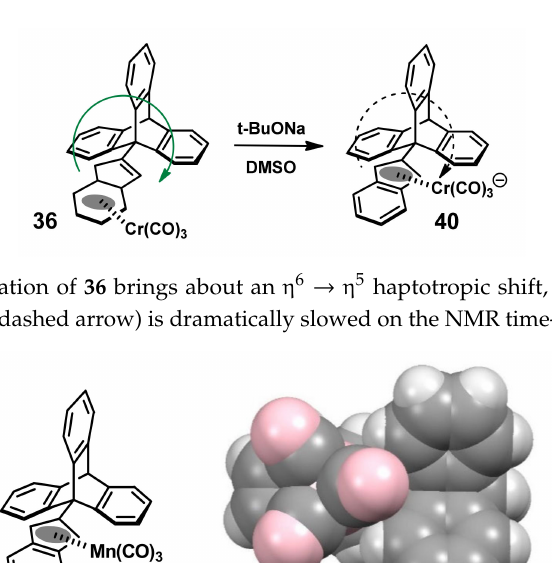
Figure 3. Palladium-catalysed formation of C–C bonds in the tripodal rigid non-degenerate shuttle, 4